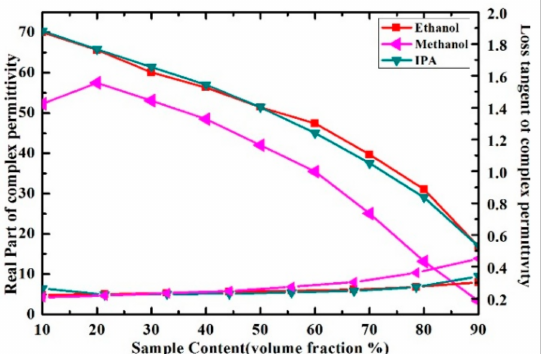
Figure 14. Measured results of real part and loss tangent of ethanol-water, methanol-water and IPA-water solution at the frequency of 5.05 GHz.